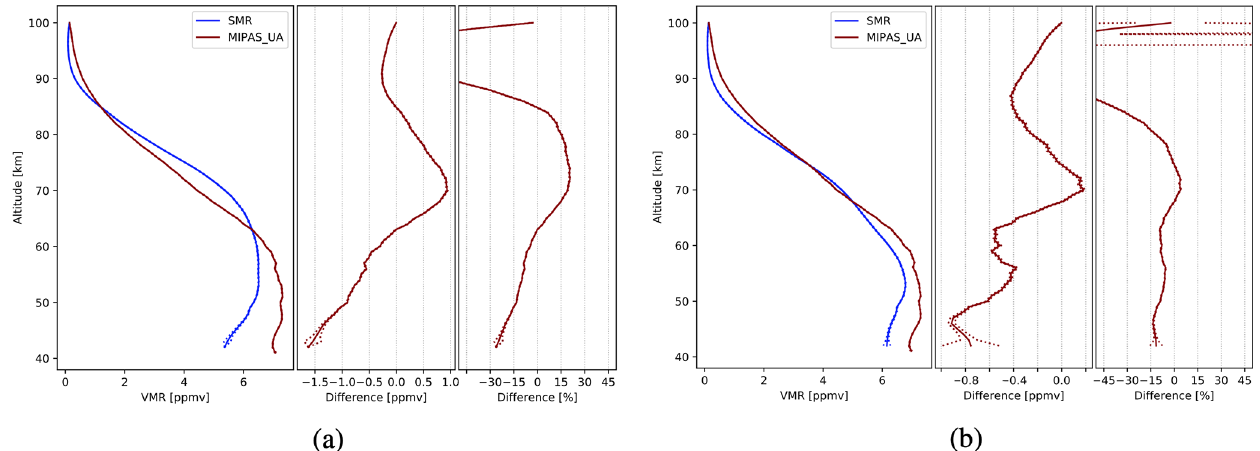
Figure 9. Comparison of SMR H 2 O profiles, from FM13 (a) and FM19 (b) , with those from MIPAS upper atmosphere mode retrievals. The data plotted are global averages over the time periods indicated in Table 2. Figure characteristics are the same as in Fig. 6.